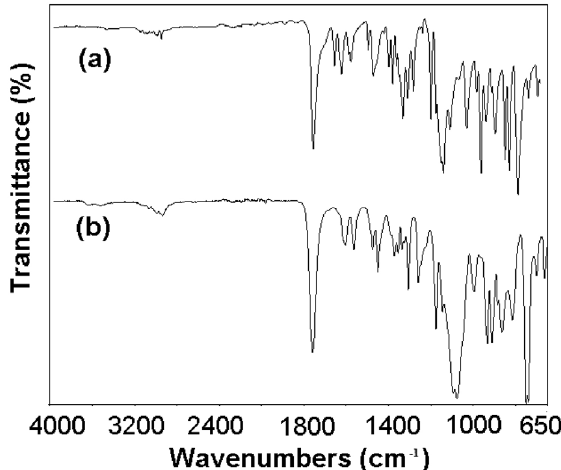
Fig. 1. FTIR spectra of a) BMKMA monomer, b) poly(BMKMA)